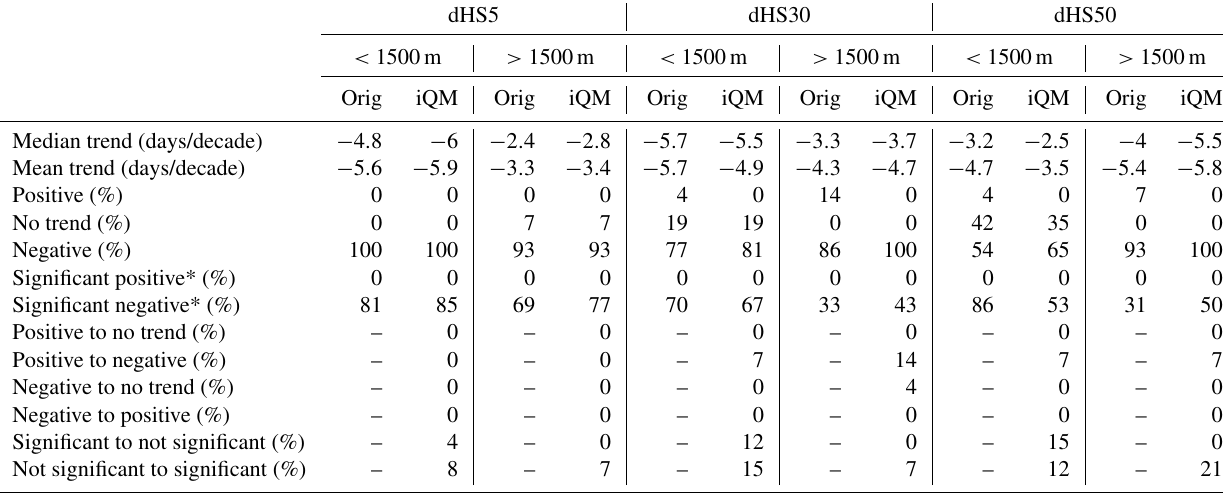
Table 2. Statistics for snow days (dHS) for the period 1961 to 2021 on a seasonal basis with thresholds of 5 (dHS5), 30 (dHS30) and 50 (dHS50)cm for both original (Orig) and interpQM-homogenised data (iQM).